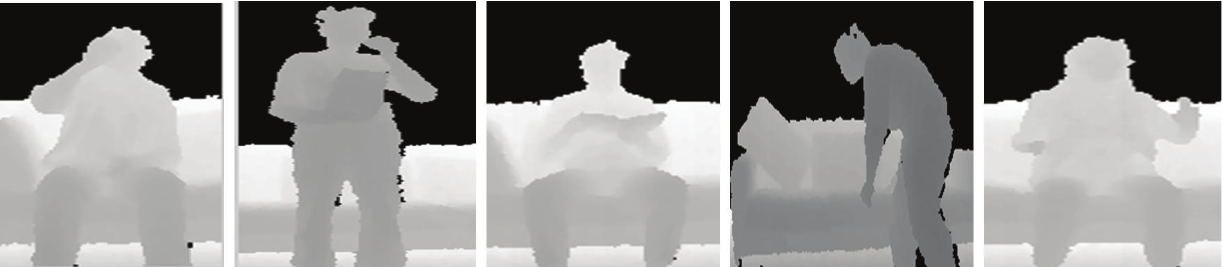
Figure 13: Some depth images used in MSRDailyActivity3D dataset.